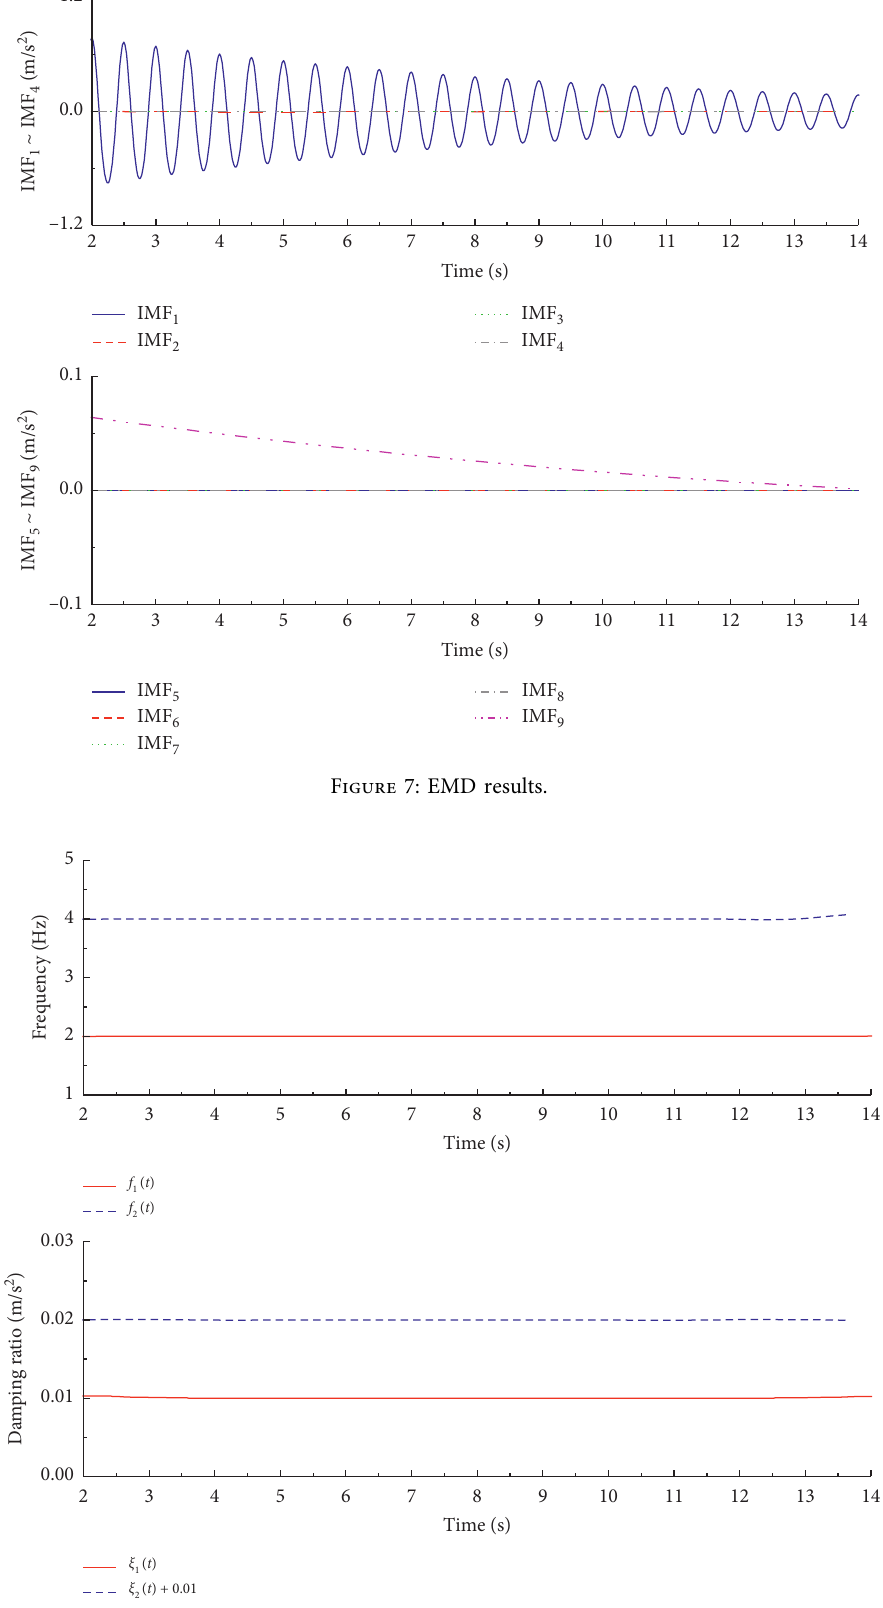
Figure 8: Instantaneous frequency and damping ratio with low-energy